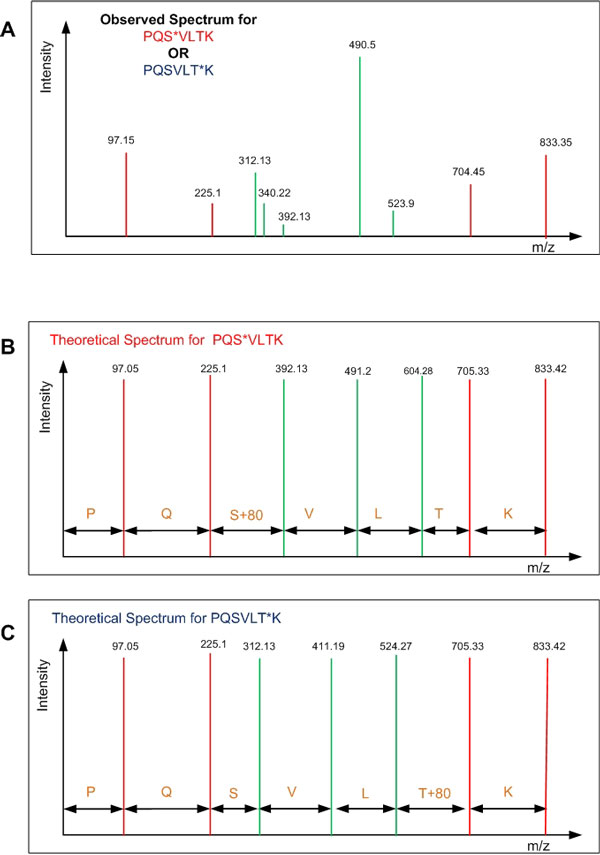
Simplified problem statement: Observed spectrum of a mono-phosphorylated peptide (PQSVLTK) is shown (A) and the problem is to determine which of the possible configuration PQS*VLTK (shown in B) or PQSVLT*K (shown in C) (* indicates phosphorylated residue) has the theoretical spectrum that corresponds best to the observed spectrum.